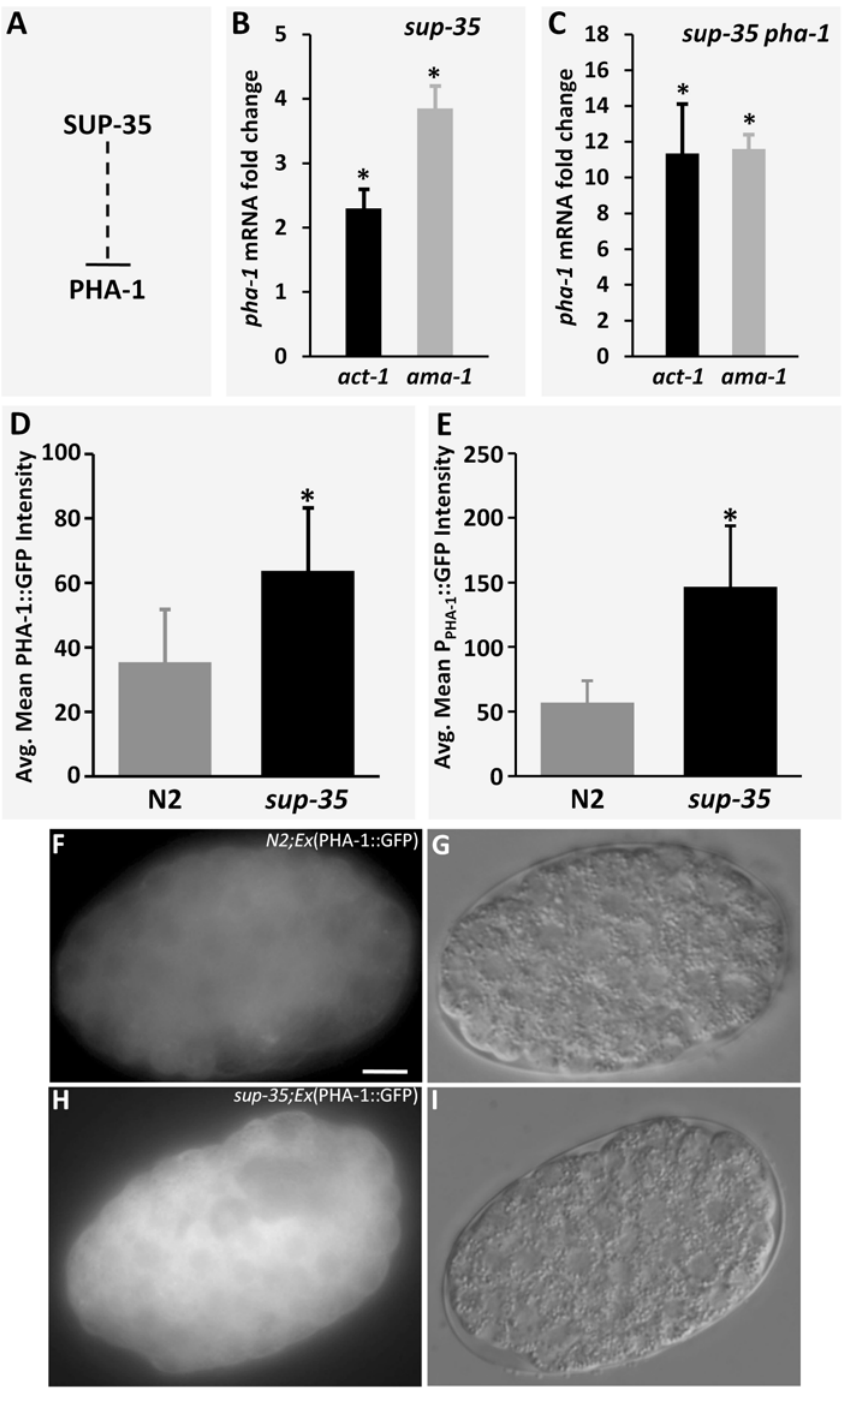
Figure 4. SUP-35 negatively regulates pha-1 . (A) Testable model for the regulation of PHA-1 by SUP-35. (B,C) Quantification of endogenous pha- 1 mRNA levels in embryos by qRT-PCR in sup-35(tm1810) single mutants (B) or sup-35(e2223) pha-1(e2123 double mutants (C) using act-1 (black bar) and ama-1 (gray bar) as loading controls. Fold changes were obtained after normalizing to wild type (B) or pha-1(e2123) single mutants (C). Error bars represent s.e.m. Means of the indicated groups were analyzed for significance using a two-tailed Student’s t -test (*p , 0.0). Quantification of PHA- 1::GFP (D) and P pha-1 ::GFP (E) fluorescence in wild-type and sup-35(tm1810) mutants. The average mean GFP intensity for each genotype was analyzed for significance using a two-tailed Student’s t-test (*p , 0.0001). (F–I) Representative GFP (F,H) and corresponding DIC (G,I) images of PHA-1::GFP expression in wild type (F,G) and sup-35(tm1810) mutants (H,I). Digital camera exposure times were identical for all embryos assayed. Mean GFP intensities were determined as described in Materials and Methods. Scale bar in F, 10 m m for F–I.